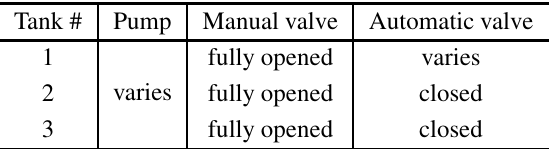
Table 6. Pump/valve-controlled scenario: